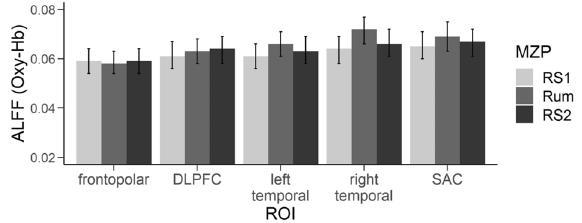
Figure 4. Interaction of ROI and condition in ALFF (Oxy-Hb) with error bars indicating standard errors. RS resting state, Rum Rumination induction, ROI Region of interest, ALFF Amplitude of Low Frequency Fluctuations. The scaling of the y-axis has been set to a minimum of .02 which is equal to the smallest value we measured in ALFF in this sample.